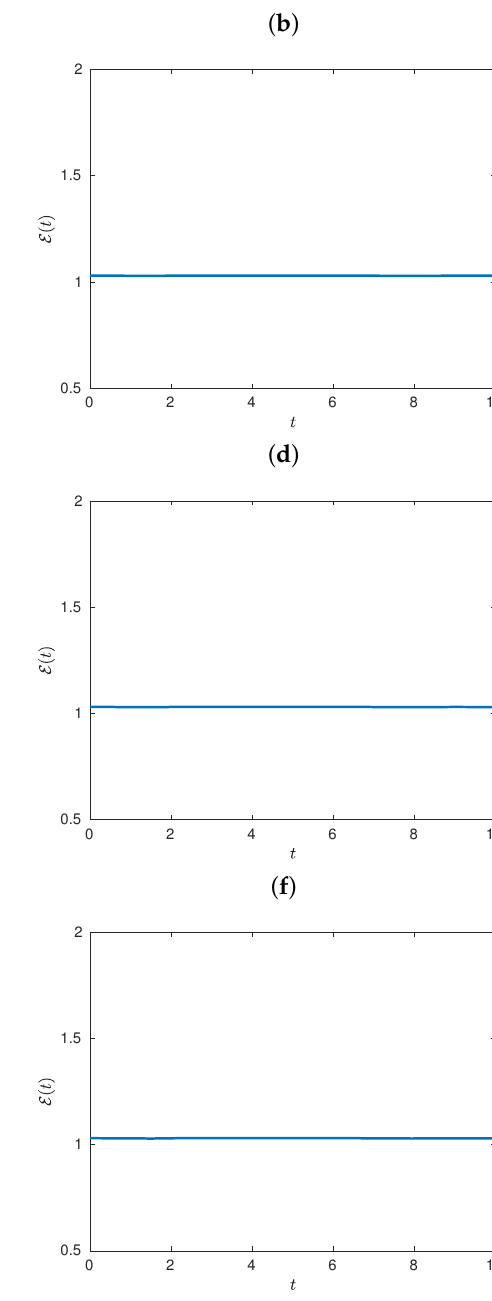
x 2 , and initial data φ 1 ( x ) = φ 2 ( x ) = 2